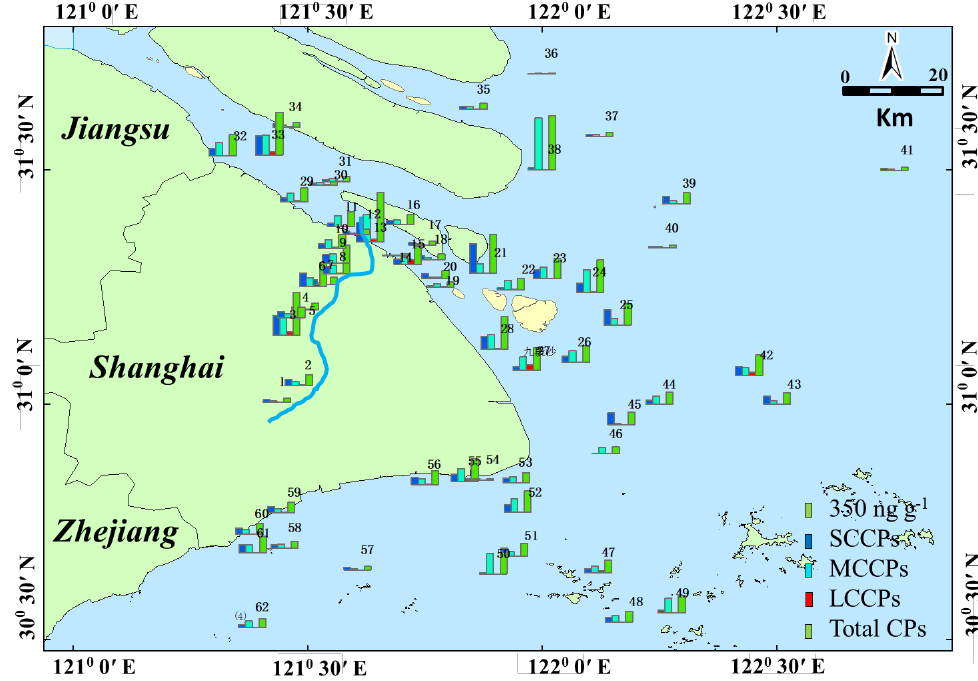
Figure 3. The map shows the spatial distribution trend of concentrations of CPs (ng g − 1 ) in the sampling points in which the blue bar is SCCPs, the light blue bar is MCCPs, the red bar is LCCPs, and the green bar is total CPs.